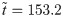
Test 2: Comparison between FOM and DL-ROM solutions for different testing-parameter instances.FOM solution (left), DL-ROM one (center) with n = 5, and relative error ϵk (right) at t˜=153.2 ms, for the testing-parameter instance μtest = 0.6125 cm (top) and μtest = 0.9125 cm (bottom). In both cases the relative error ϵk is below 1%.